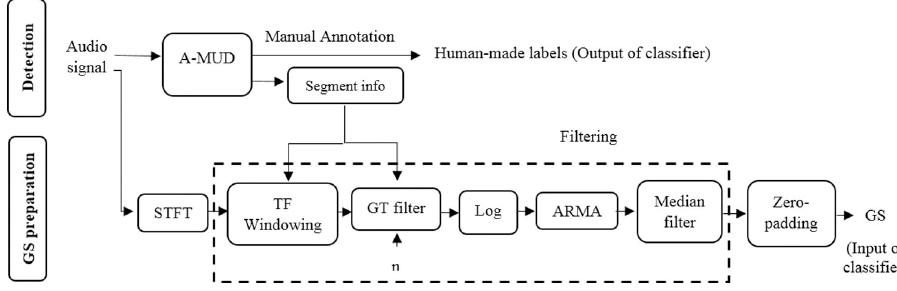
Fig 1. Block diagram showing the procedure for USV detection and input preparation for the classifier. n is the Gammatone (GT) filter order. STFT, A-MUD, ARMA, and GS are the abbreviation for short-time Fourier transform, automatic mouse ultrasound detector, autoregressive moving average, and Gammatone spectrograms, respectively. TF in ‘TF windowing’ is the abbreviation for time-frequency. In this step, we restrict the spectrogram to the time of interest, where the segment is detected, and to the frequency of interest, i.e., 20 kHz to 120 kHz.